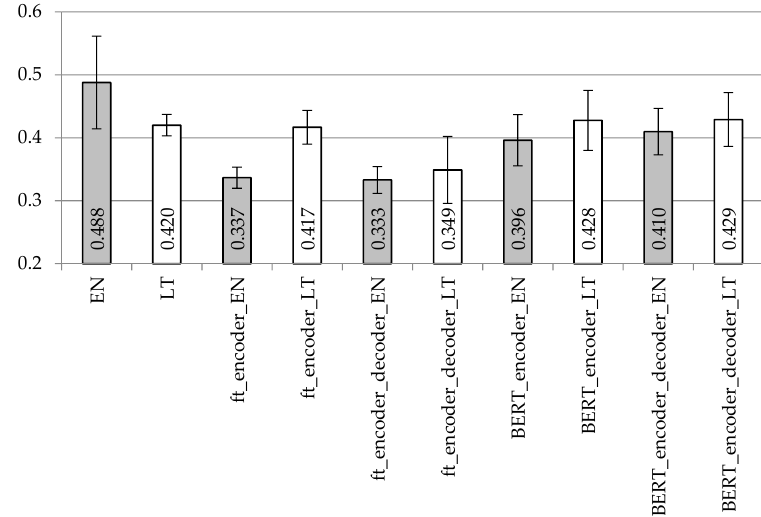
Figure 8. Averaged BLUE scores with confidence intervals using the LSTM2 encoder and LSTM decoder model with different vectorization types on the dataset with separated punctuation.